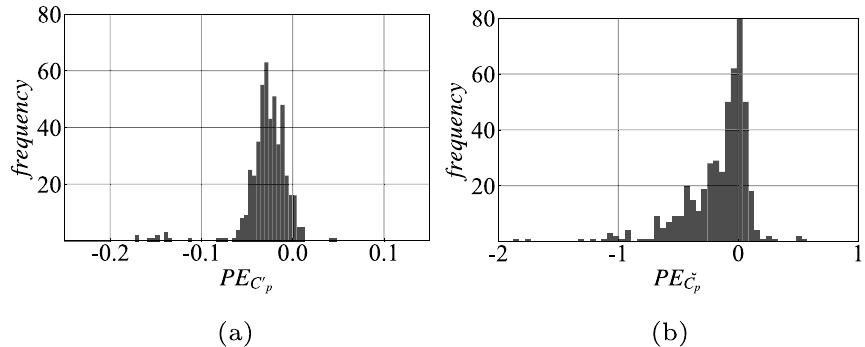
Fig. 13 The frequency distributions of ( a ) PE C ′